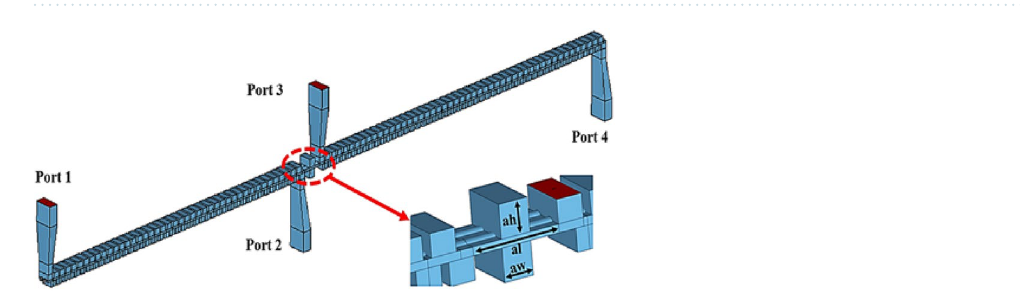
Figure 2. ( a ) Dispersion characteristic of double-mode SDV-SWSs with 20 kV electron beam line. ( b ) Interaction impedance of SDV slow-wave circuit.